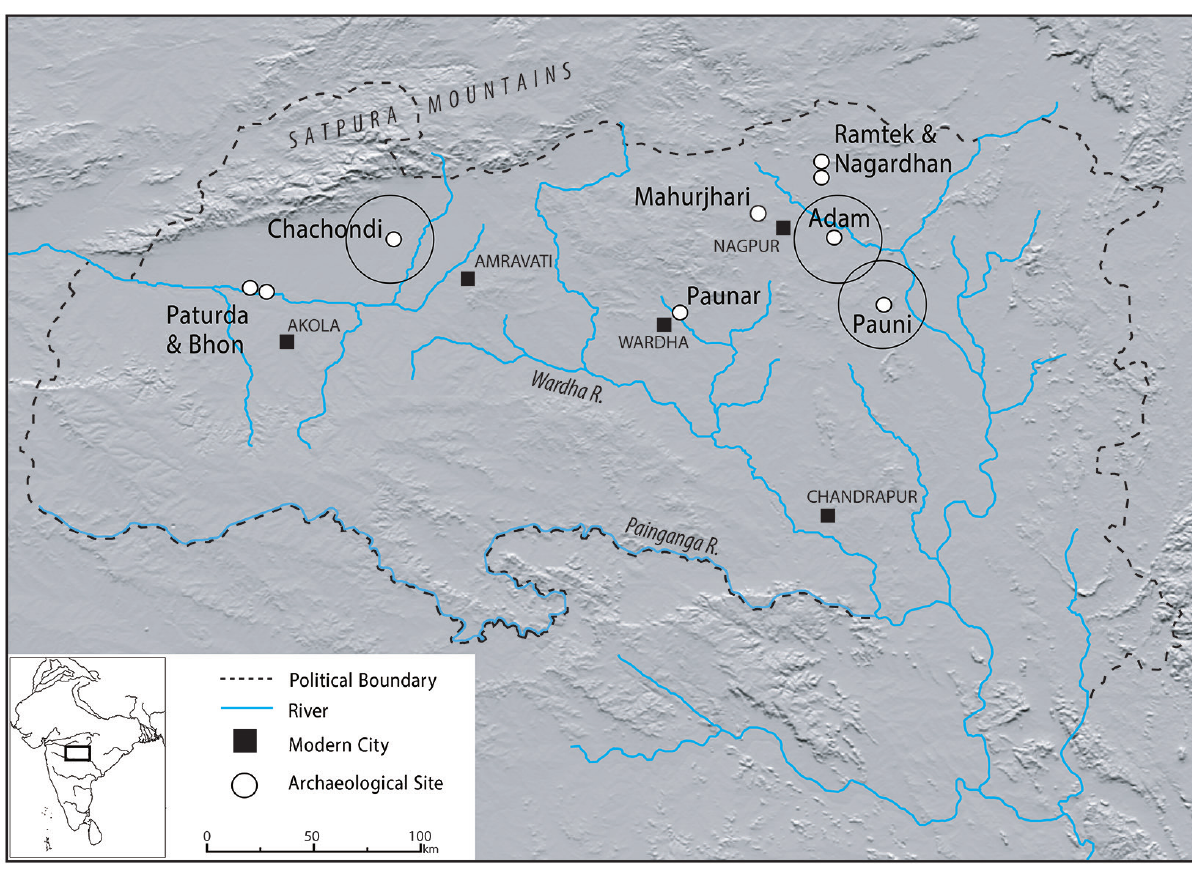
Figure 2: Map of Vidarbha illustrating the locations of survey zones and excavated sites that have provided comparative